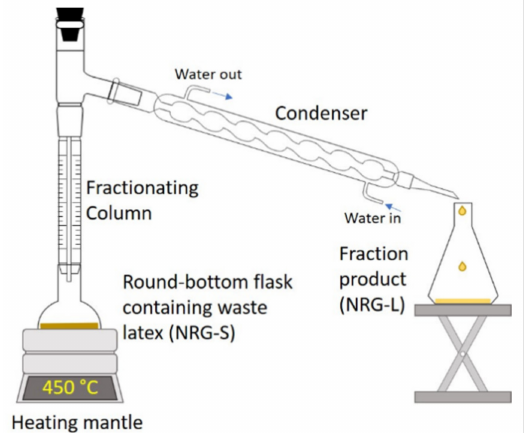
Figure 1. Fractional distillation setup for waste NRG fractionation